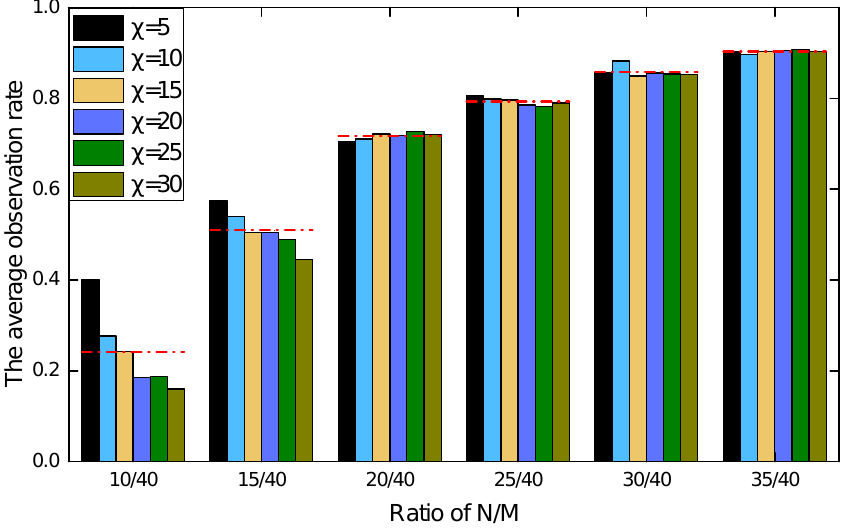
Figure 9. The effect of parameter χ on search